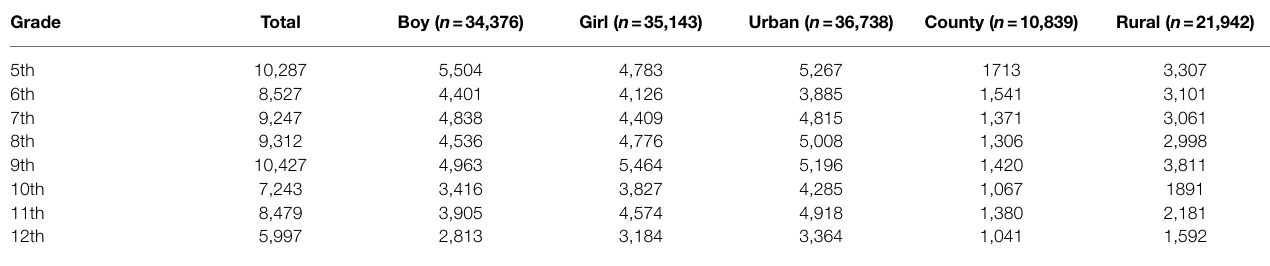
TABLE 1 | The number of participants in each